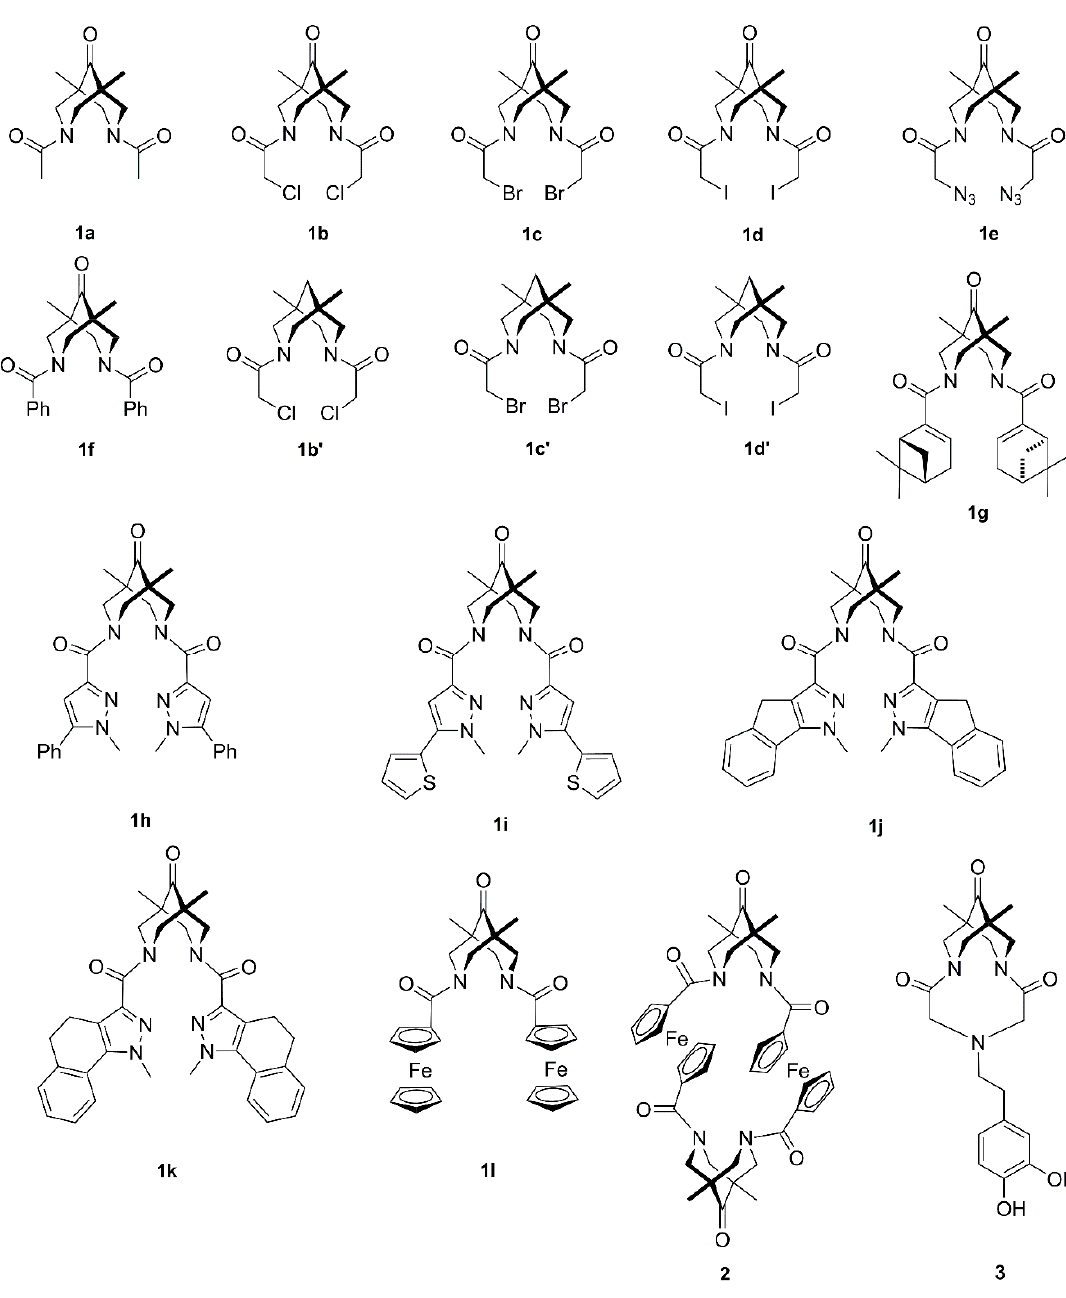
Figure 1. The structures and numbering of compounds discussed in this work.